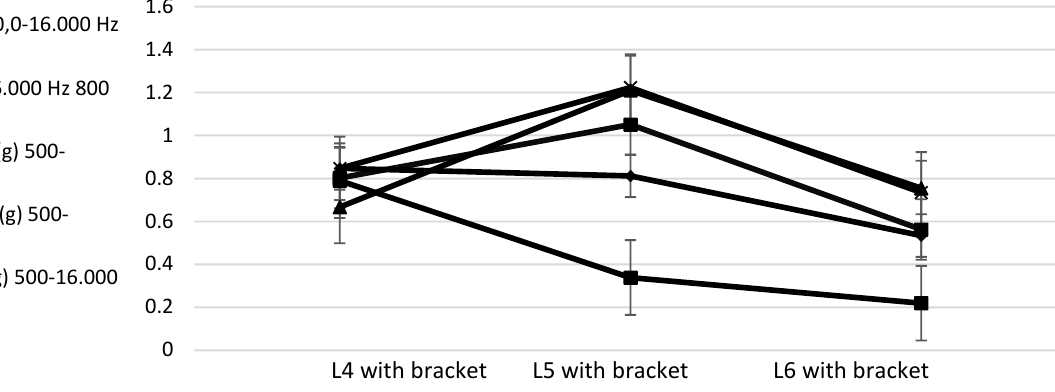
Figure 11. Bearing vibration acceleration at a speed of 1180 min –1 . The obtained results indicate that the largest vibrations were at the L5 location, at a rotation speed of 1180 min − 1 . This indicates that the largest vibrations of the